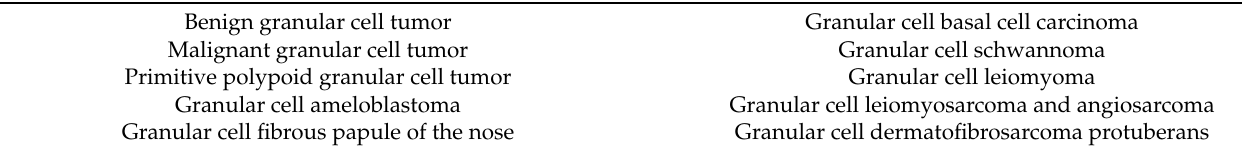
Table 1. Neoplasm with granular cell